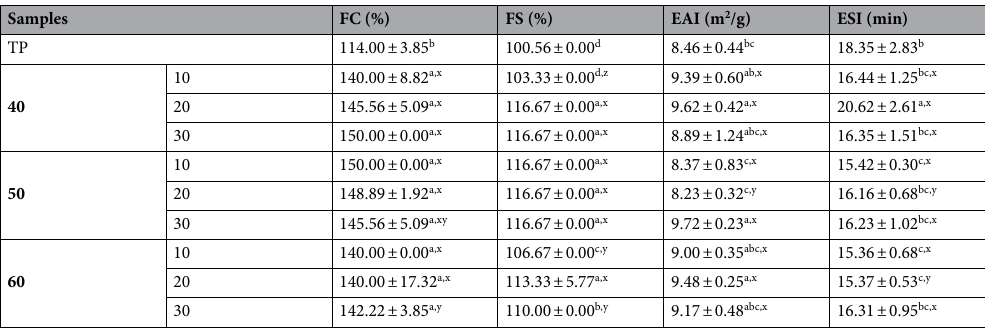
Table 3. Foaming and emulsifying properties of protein extracted from Bombay locust by ultrasound-assisted process under different conditions. Data are expressed as mean ± standard deviation (n = 3). FC, foaming capacity; FS, foam stability; EAI, emulsion activity index; ESI, emulsion stability index; TP, Typical extraction process (without ultrasound-assisted process). 40, 50, 60; Amplitudes of ultrasound-assisted process (%). 10, 20, 30; Ultrasonication times (min). a,b,c … indicated significant differences of data in the same column ( P < 0.05). x,y,z indicated significant differences of data comparing in the same ultrasonication time ( P <